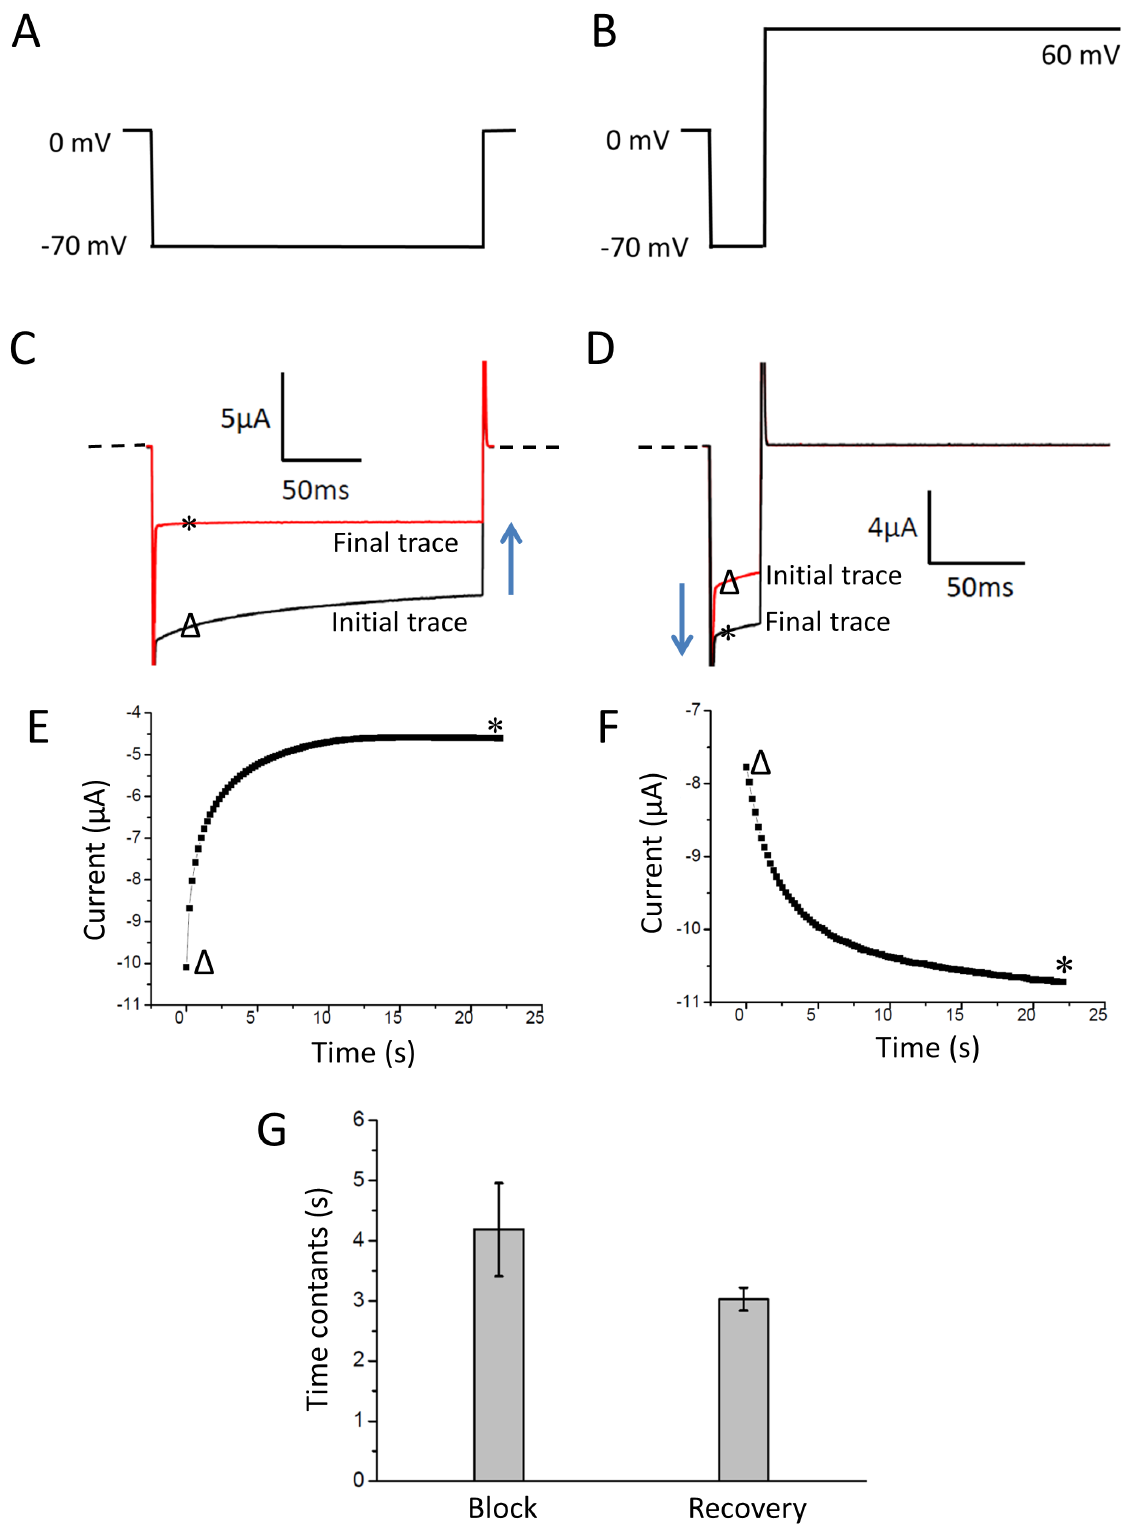
Figure 2. The kinetics of inhibition and recovery induced by Mg 2 + wash-in or wash-out. (A) and (B) are the protocols used to inhibit, activate the currents, respectively. The protocols will repeat until the currents reach the plateau. (C) and (D) are the representative current traces of inhibition and recovery processes. D and * show the currents of initial and final traces. (E) and (F) are the inhibition and recovery kinetics. D and * show current corresponding to C and D. (G) shows the summary data of the time constants corresponding to E and F. Data represent means 6 SEM for 7 experiments.